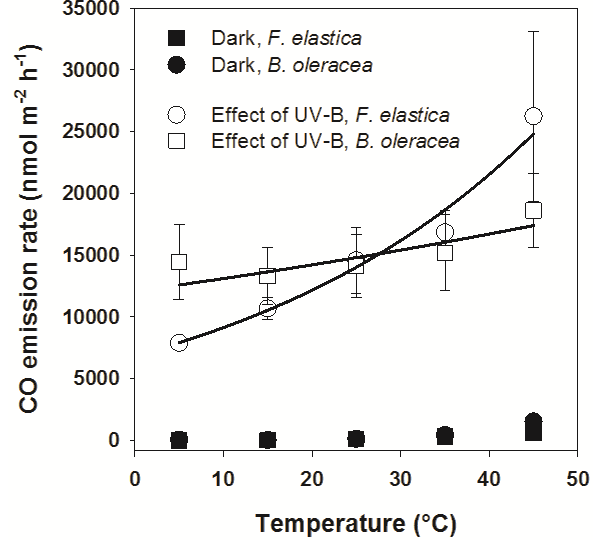
Fig. 4. Temperature dependence of UV-induced CO emission rate (ER) by leaf (ER light – ER dark ) and dark CO emission rate (mean ± S.E.). The full lines represent exponential regression to data for leaves. See Sect. 3.2.3 for equation